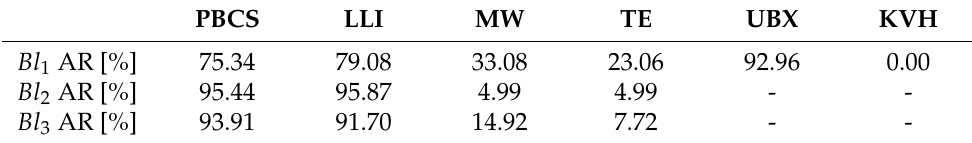
Table 6. Ambiguity resolution success ratios of the different solutions—Case Study 2.